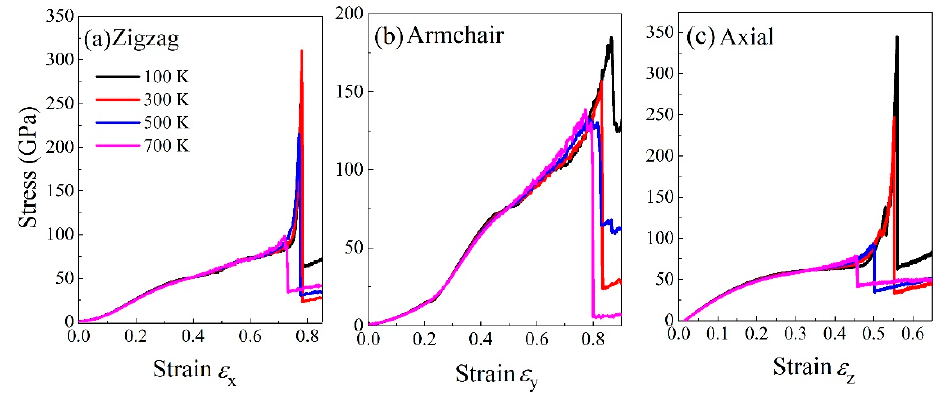
Figure 6. The stress-strain curves of BNHCs under tensile loading at various temperatures along ( a ) zigzag, ( b ) armchair and ( c ) axial directions, respectively.